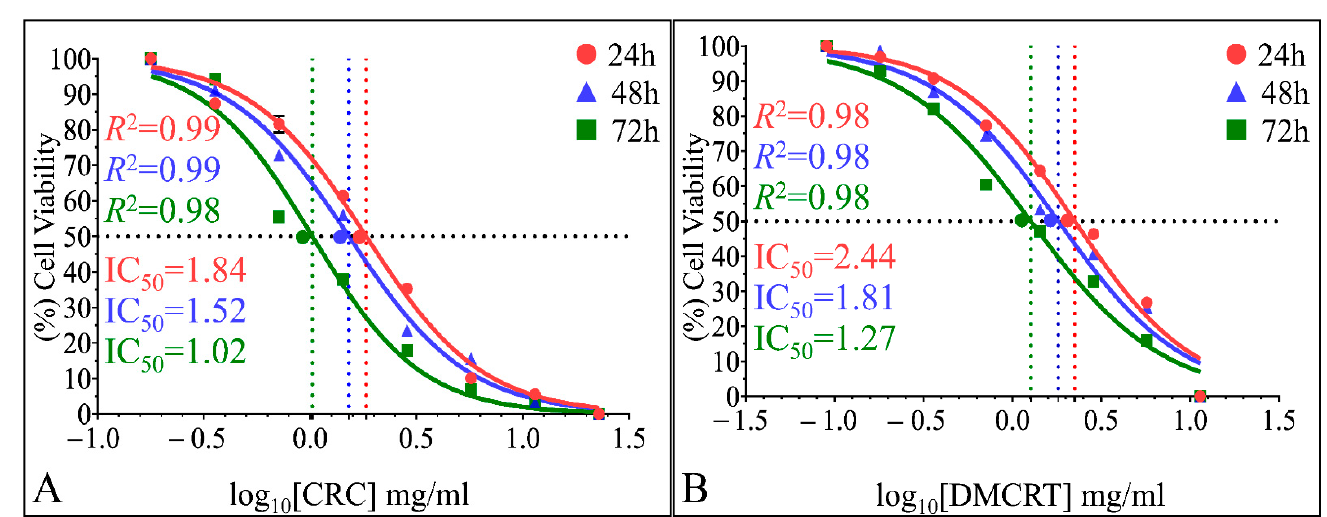
Figure 11. Calculation of IC 50 of CRCs and DMCRT on TE671 cells. IC 50 were found 1.84 mg/mL ( R 2 = 0.99), 1.52 mg/mL ( R 2 = 0.99) and 1.02 mg/mL ( R 2 = 0.98), for CRCs, at 24, 48 and 72 h, respectively ( A ). In addition, the IC 50 for DMCRT was estimated to be 2.44 mg/mL ( R 2 = 0.98), 1.81 mg/mL ( R 2 = 0.98) and 1.27 mg/mL ( R 2 = 0.98) at 24, 48 and 72 h, respectively ( B